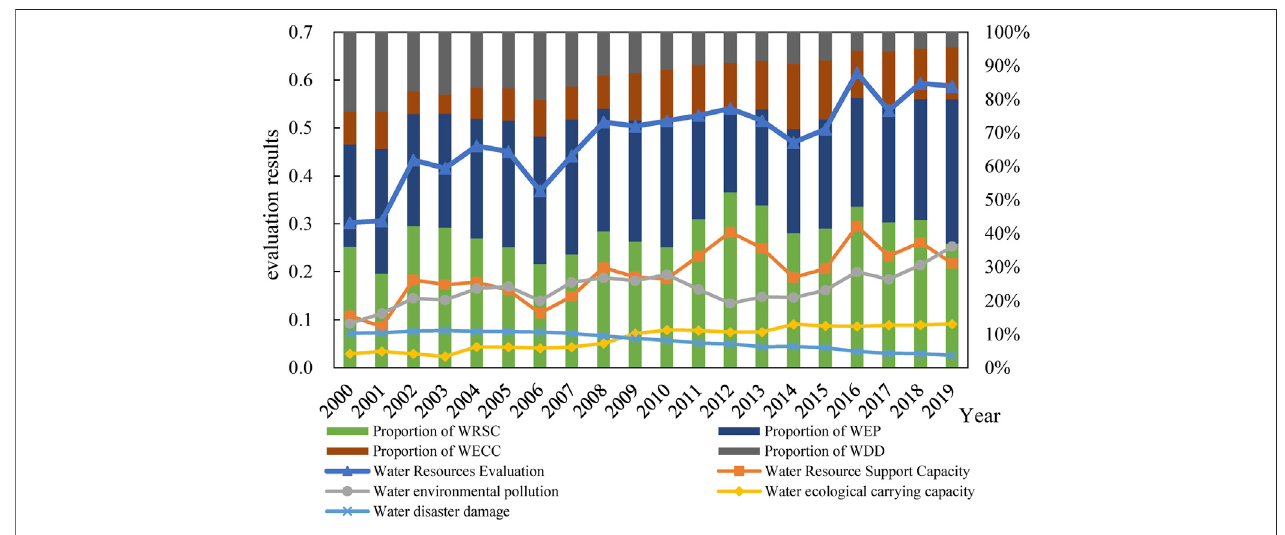
FIGURE 2 | Comprehensive evaluation results of water resources in Hebei Province from 2000 to 2019.